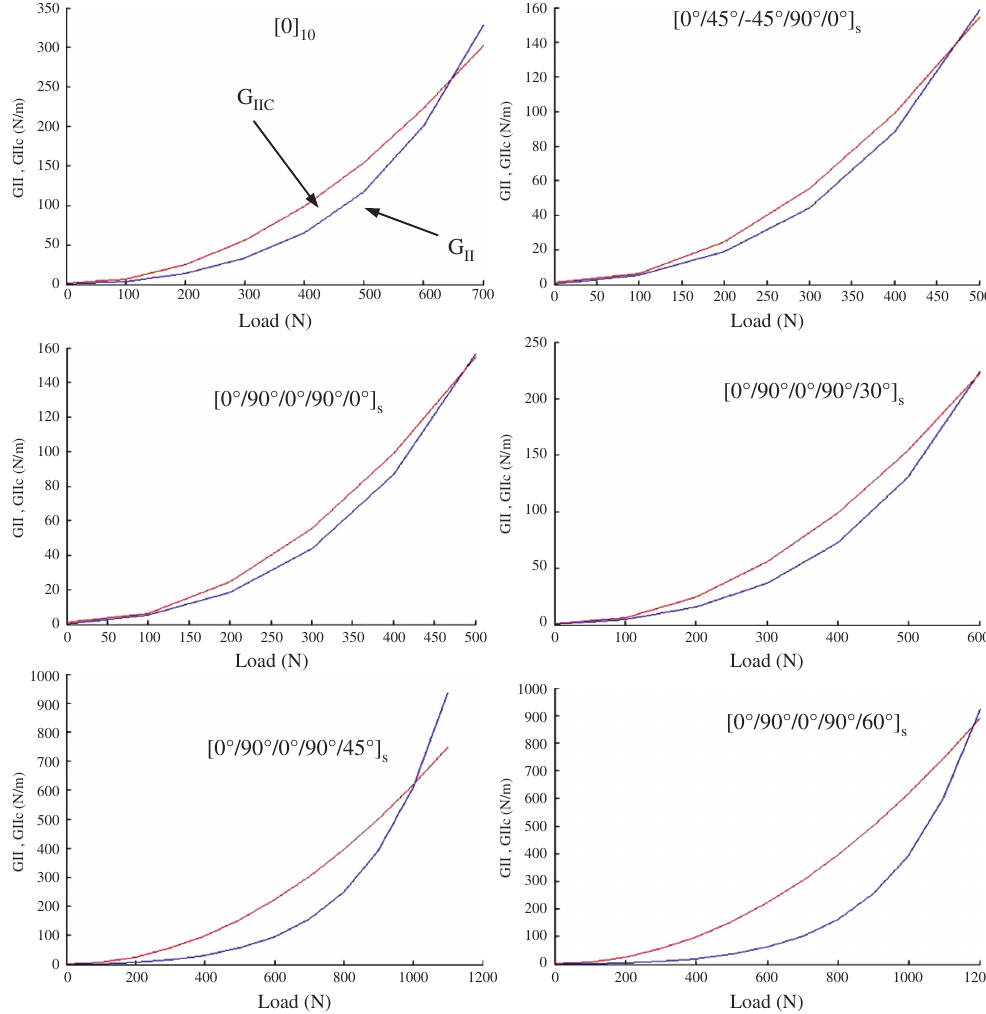
Figure 7 Energy release rate-load diagram for carbon/PEEK (AS4/APC2) obtained from meshfree